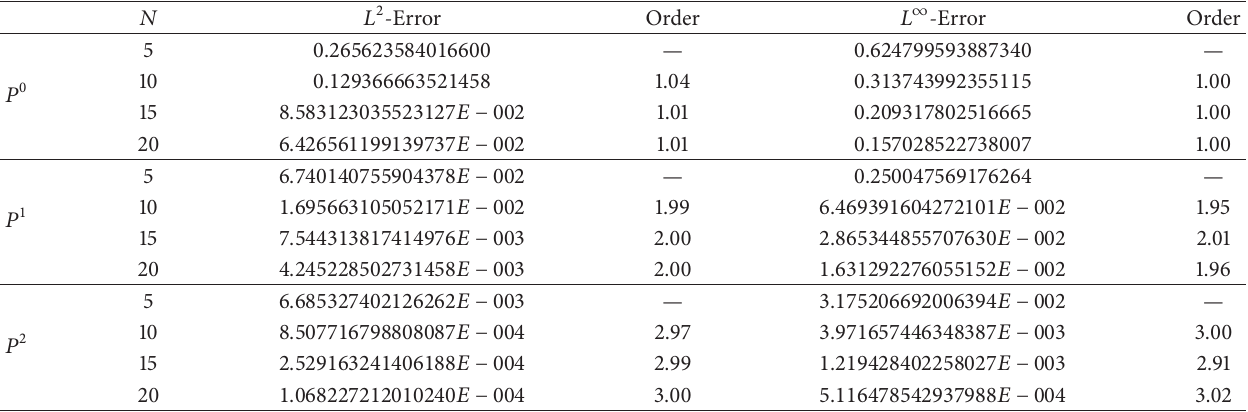
20 4.245248206073015𝐸 − 003